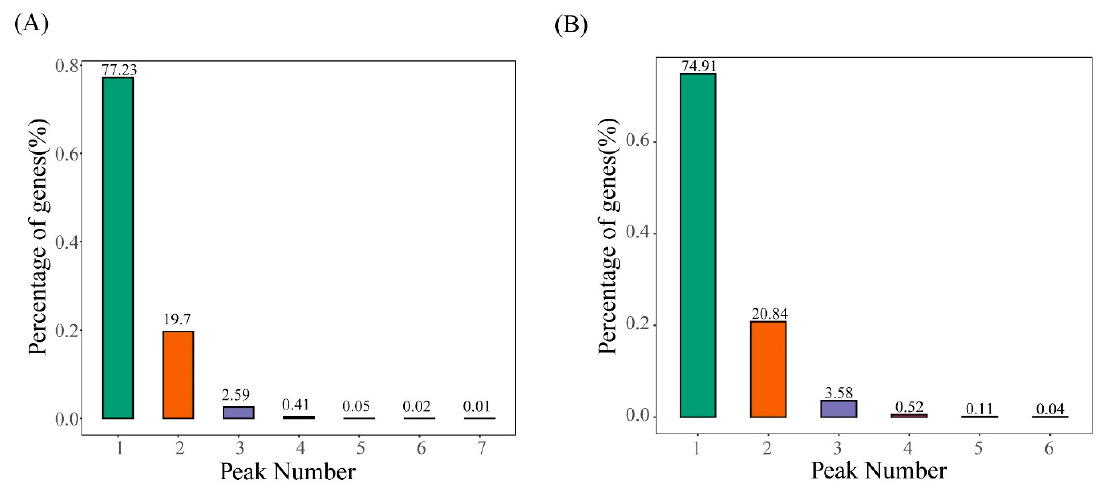
Figure 3. Statistics on the proportion of genes containing different numbers of m 6 A peaks. ( A ) CK group; ( B ) T43 group.